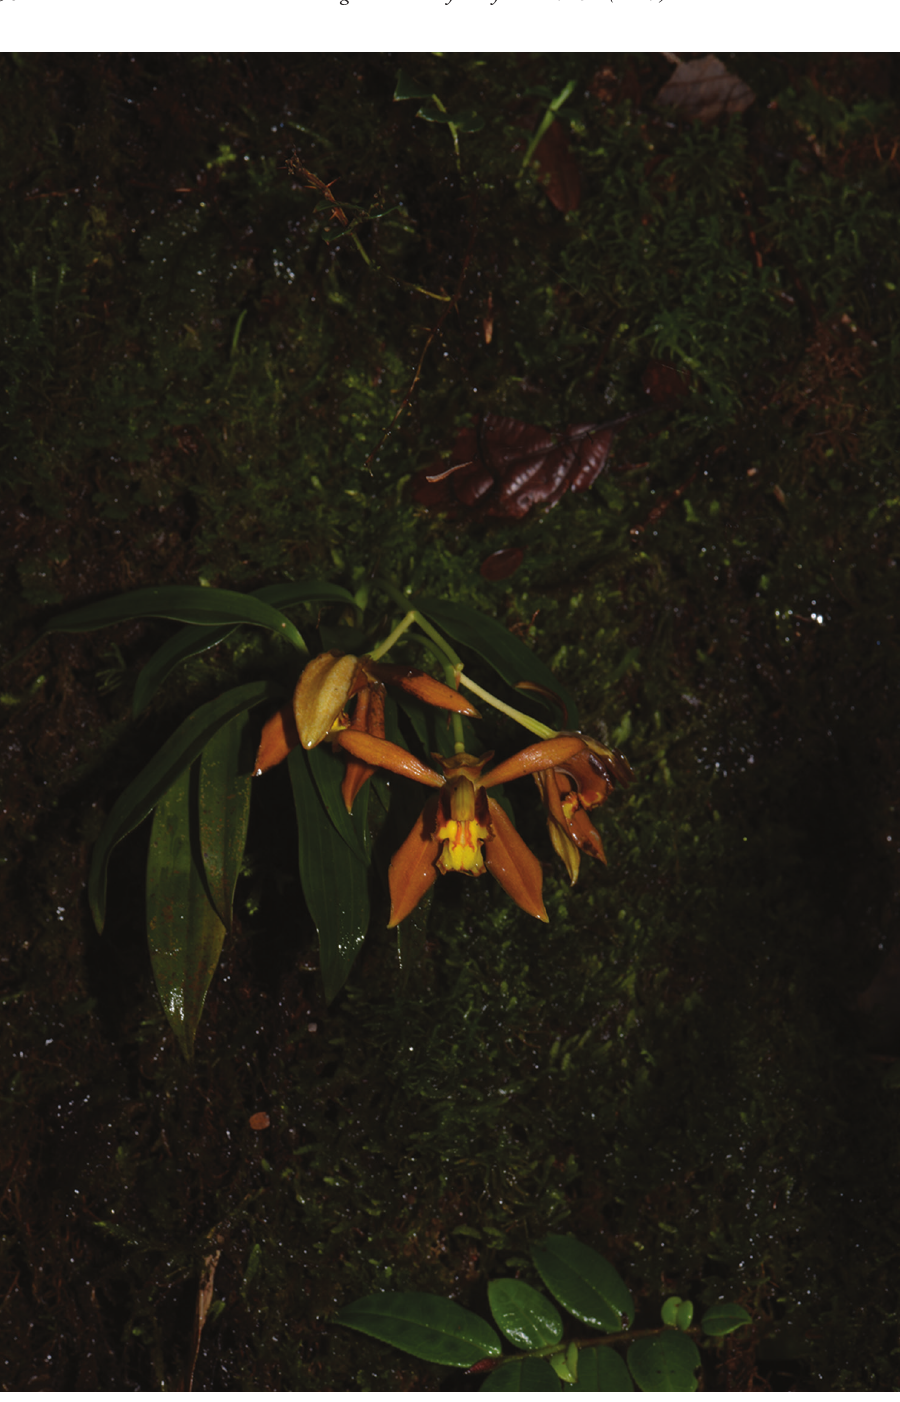
Figure 2. Habit of Coelogyne putaoensis . Photo by X.H.